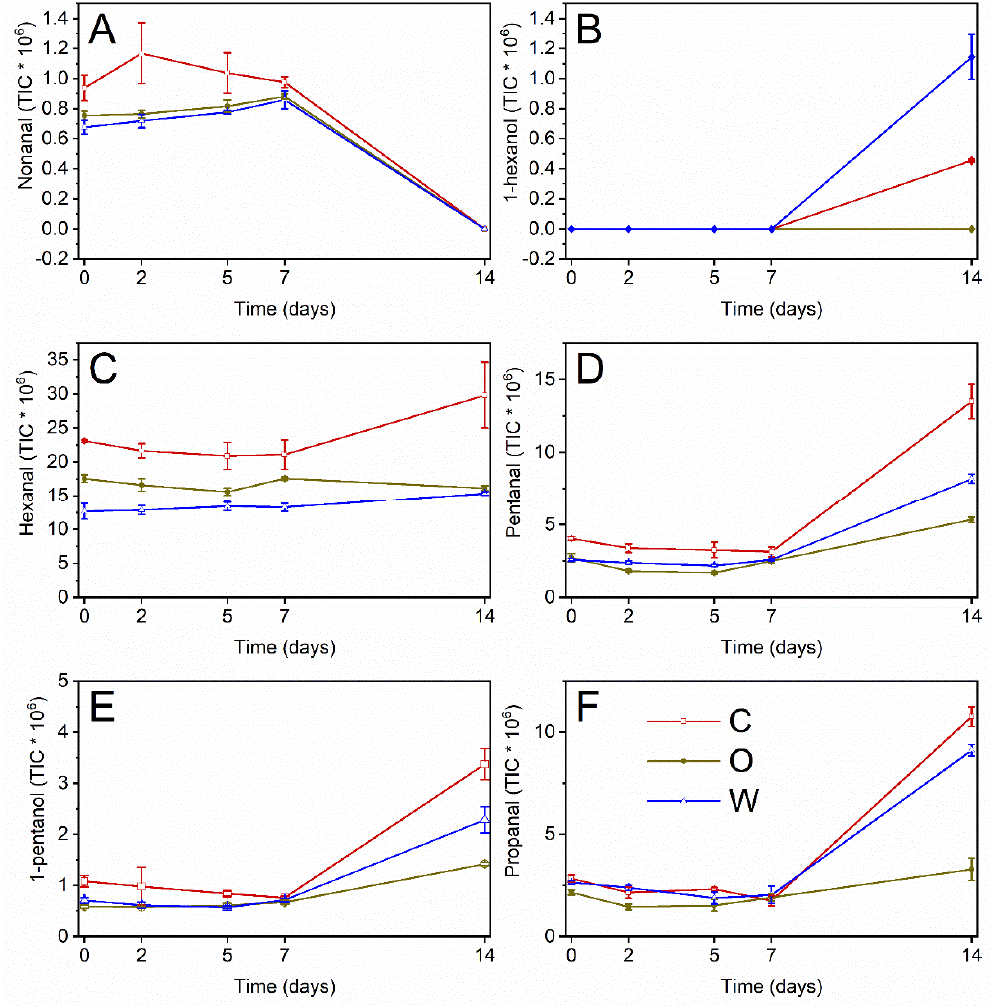
Figure 5. Trends of selected volatile compounds during accelerated oxidation of O / W emulsions added with OPAs. Mean values ± standard deviation ( n = 3). C, control emulsion; O, emulsion with OPA added to the oil phase; W, emulsion with OPA added to the water phase. ( A ) nonanal; ( B ) 1-hexanol; ( C ) hexanal; ( D ) pentanal; ( E ) 1-pentanol; ( F ) propanal.